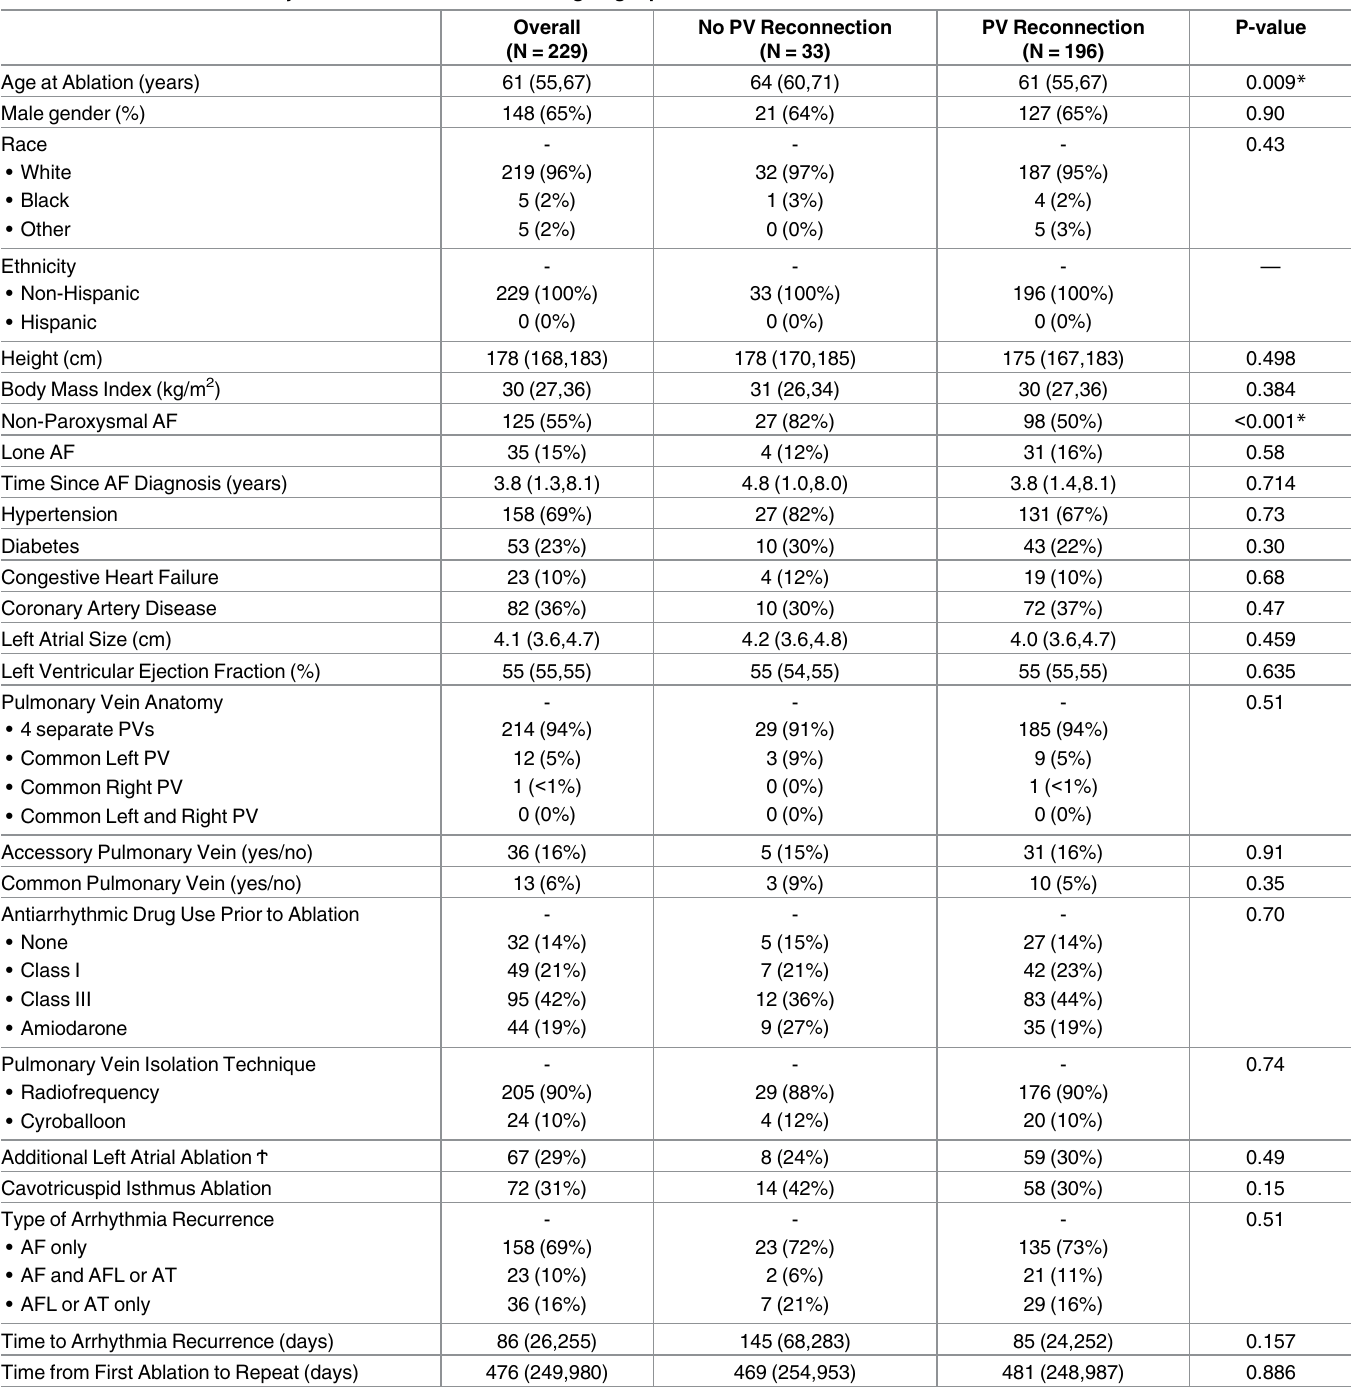
Table 1. Characteristics of subjects with AF recurrenceundergoing repeat